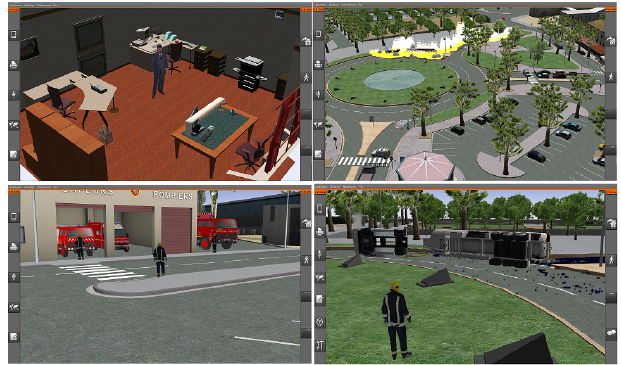
Figure 1. Screenshot from SIMFOR project